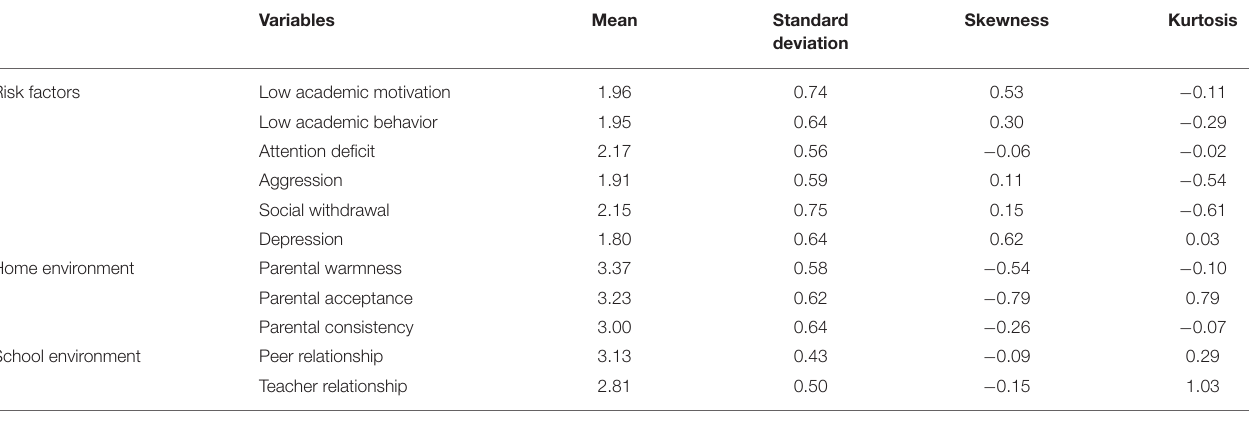
TABLE 2 | The descriptive statistics of study variables.